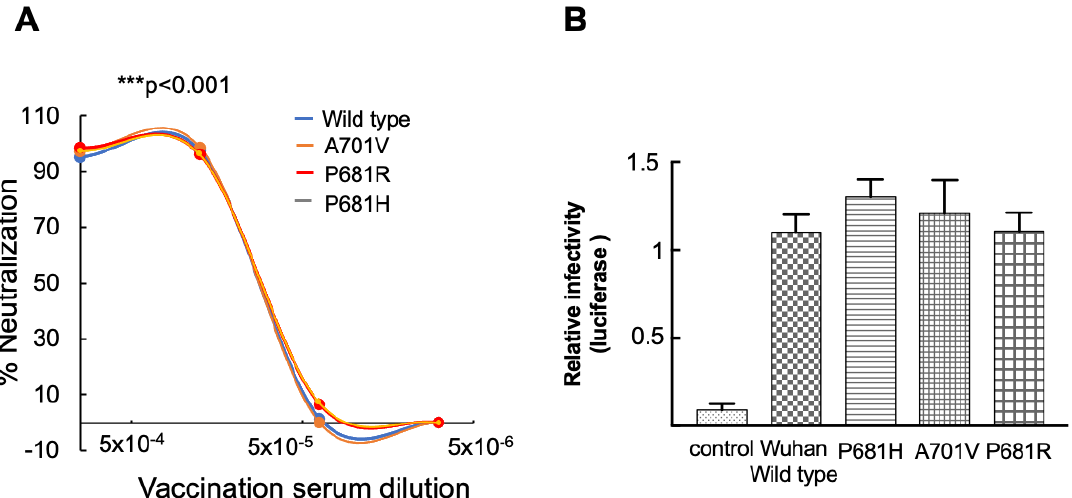
Figure 1. Furin Cleavage Site spike mutations have no impact on neutralizing potency against post-vaccination sera and on viral infectivity. ( A ) Neutralizing potential of pseudoviruses that carry Furin Cleavage Site mutations against post-vaccination sera-neutralization assays were performed by transducing HEK293T-ACE2 cells with a pseudovirus displaying a wild-type SARS-CoV-2 spike or its FCS-P681H V710A P681R mutants, in the presence of increasing dilutions of sera drawn from post vaccinated individuals. In addition, 48 h post transduction, cells were harvested, and their luciferase readings were monitored. Neutralizing potency was calculated at increased serial dilutions, relative to transduced cells with no sera added. Neutralization, NT 50 , is defined as the inverse dilution that achieved 50% neutralization. Results are the average of two independent biological experiments. Triplicates were performed for each tested serum dilution. Black bars represent geometric mean of NT 50 values, indicated at the top. Statistical significance was determined using a one tailed t -test *** < 0.001; ( B ) infectivity levels of pseudoviruses carrying Furin Cleavage Site mutations. Pseudoviruses bearing wild-type SARS-CoV-2 spike or the indicated FCS-P681H, A701V, and P681R spike mutants were used to transduce HEK293T-ACE2 cells. Equal viral loads were normalized based on p24 protein levels. In addition, 48 h post transduction, cells were harvested, and their luciferase readouts were monitored. Bar graphs show mean values ± SD error bars of three independent experiments.